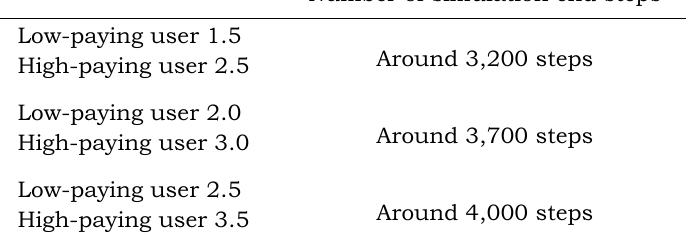
Table 3. The results of sensitivity analysis for changes